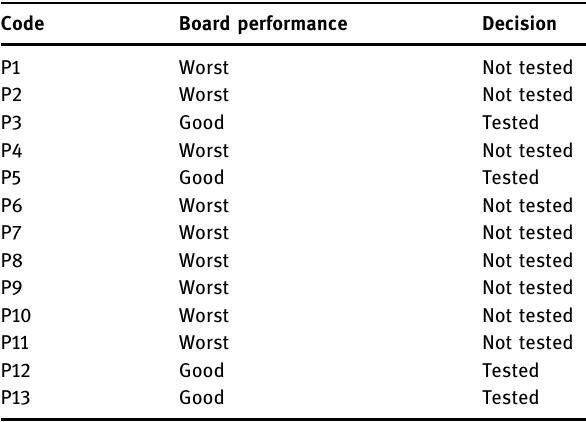
Table 4: Mechanical properties of